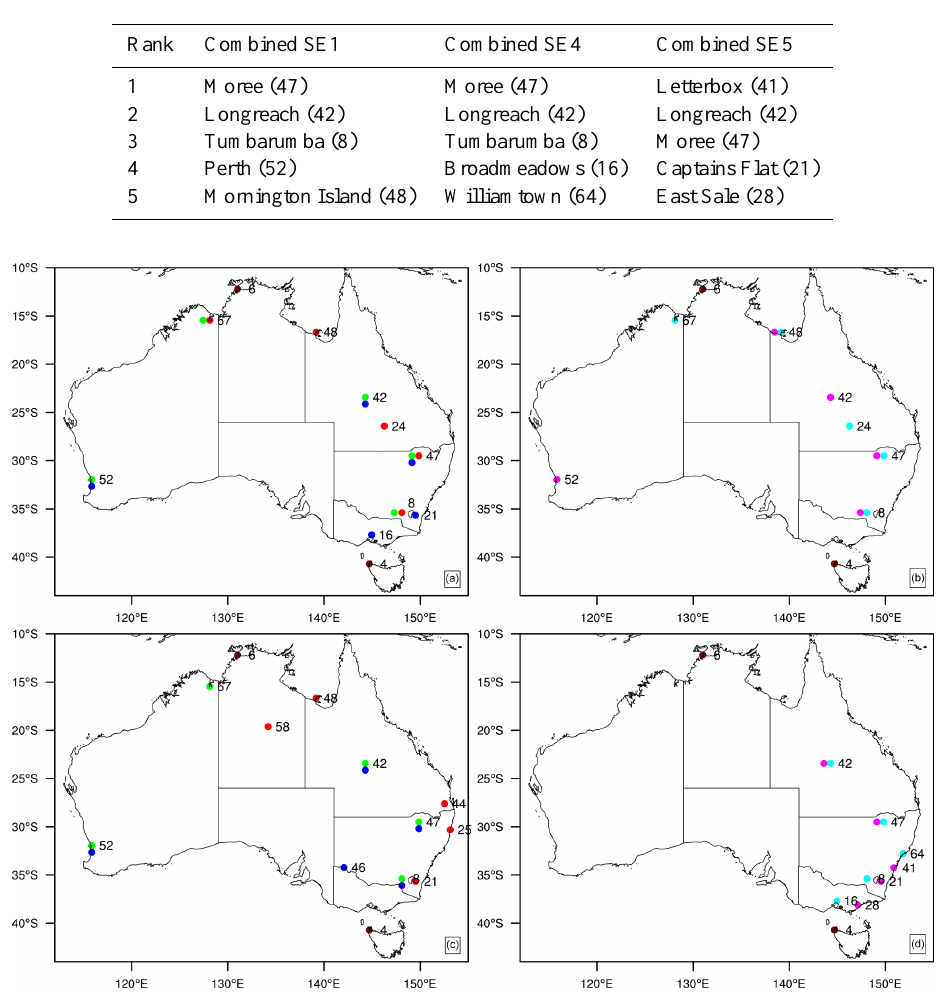
Table 5. Ranking for new stations added to the base network in terms of their ability to reduce the uncertainties on CO 2 , CH 4 and N 2 O flux estimates for some of the sensitivity tests: SE1 – using equal contributions of the three GHGs; SE4 – using GWP weights and distance measure; and SE5 – using GWP weights, distance measure and increased observational uncertainties for stations close to large sources. The station number is provided in brackets.